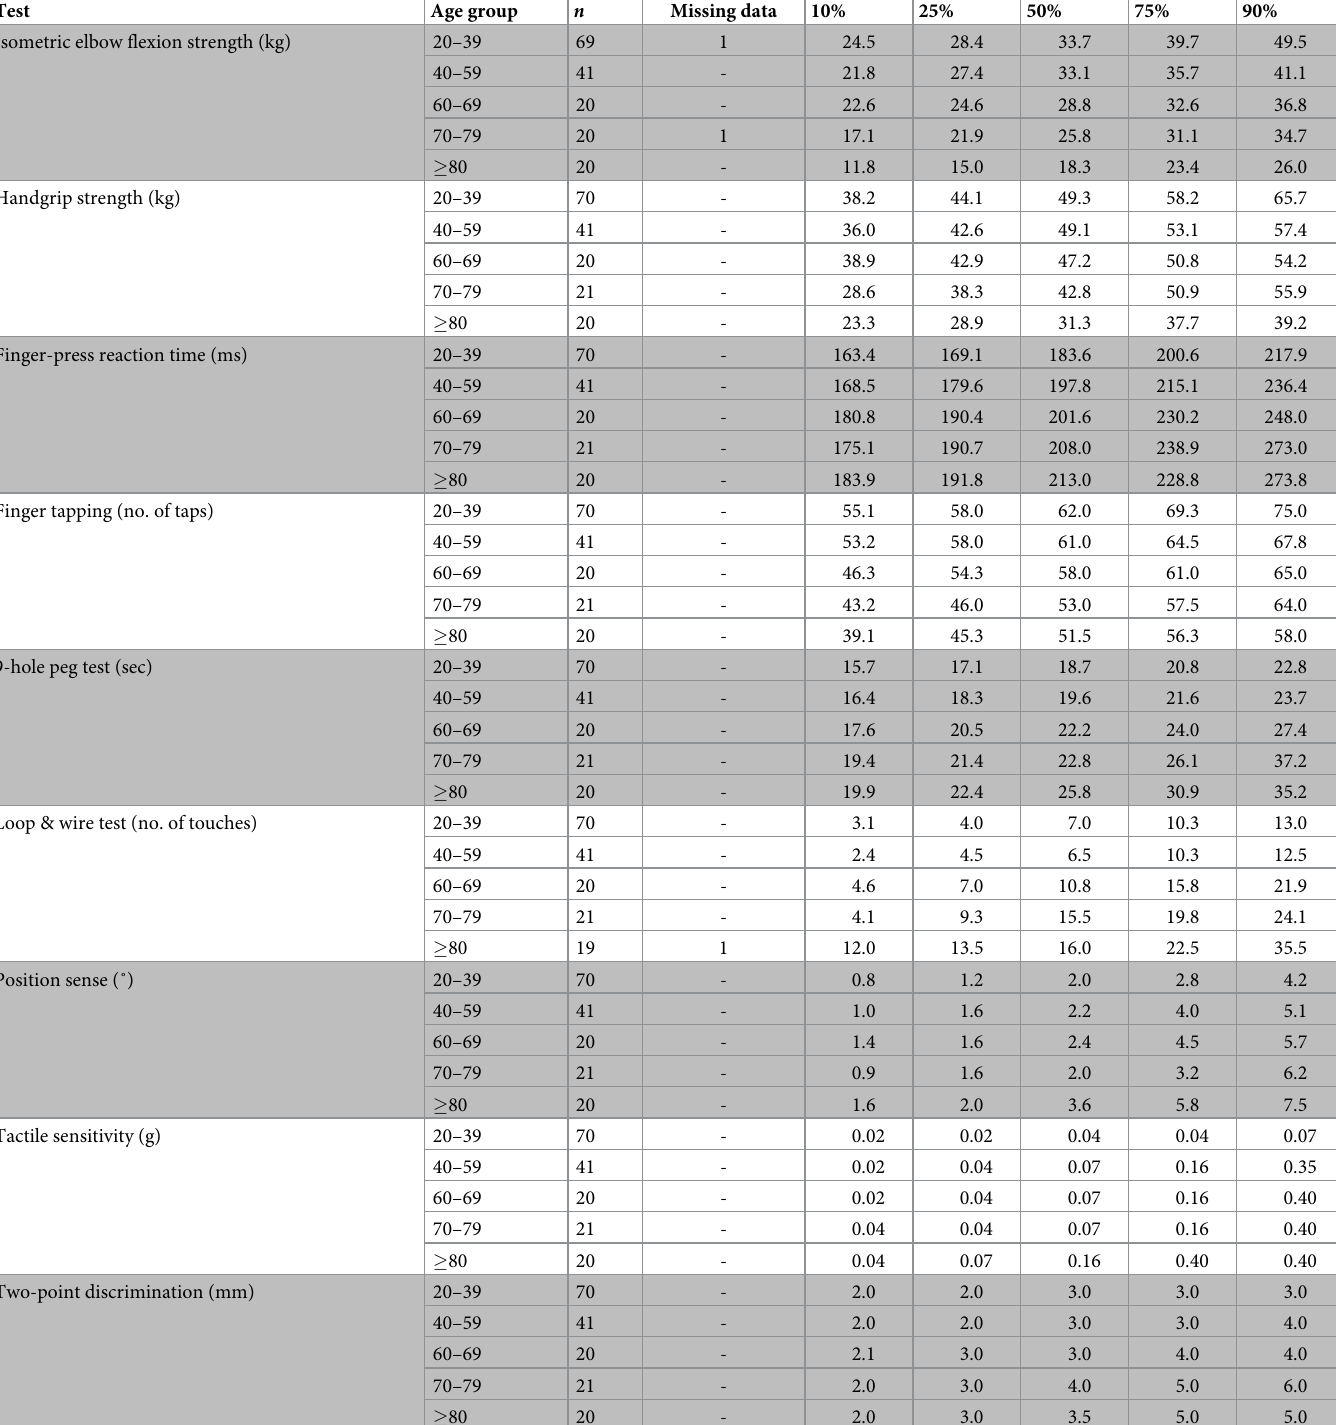
Table 2. Reference values (percentiles) for males in each upper limb PPA test for age groups 20–39, 40–49, 50–59, 60–69, 70–79 and � 80. Test Age group n Isometric elbow flexion strength (kg)